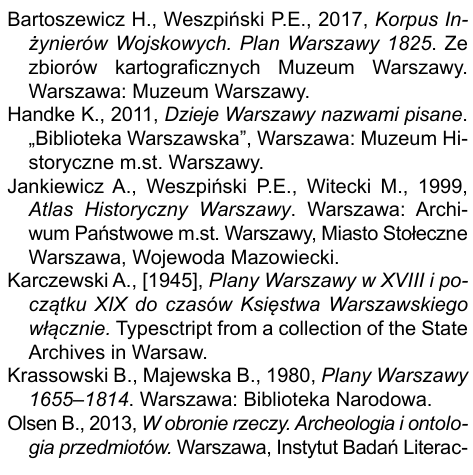
Fig. 5. Percentage of the city maps of Warsaw presenting property and administrative information in the total number of city maps in three periods